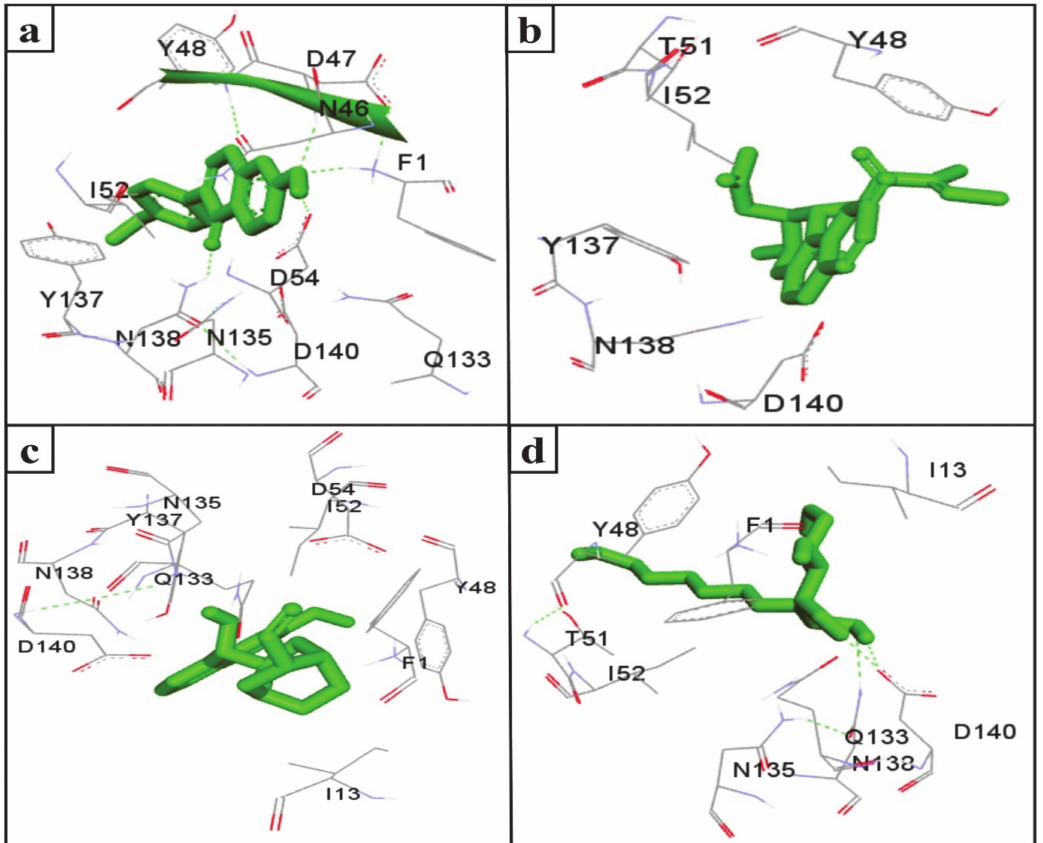
Figure 4. The amino acid residue of FimH’s interaction with formononetin ( a ), (+)-pteryxin ( b ), quinidine ( c ), and heptyl α - D -mannopyranoside ( d ). The ligands (formononetin, (+)-pteryxin, quinidine, and heptyl α - D -mannopyranoside) are represented as green stick forms and hydrogen bonds are represented as green dashed